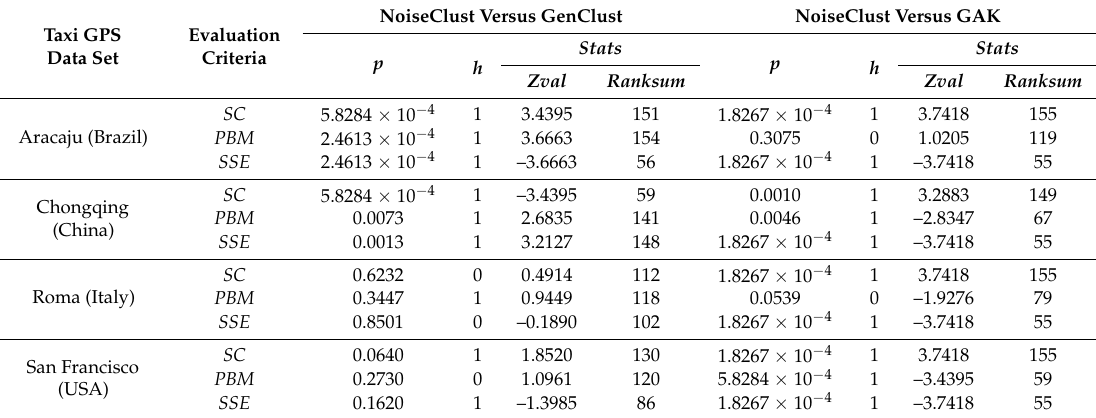
Table 5. The Wilcoxon rank sum test (WRST) testing results of SC , PBM , and SSE obtained by NoiseClust, which are statistically different from the results obtained by the GenClust and GAK clustering results ( α = 0.05, α denotes significance level parameter of the WRST (0 < α <